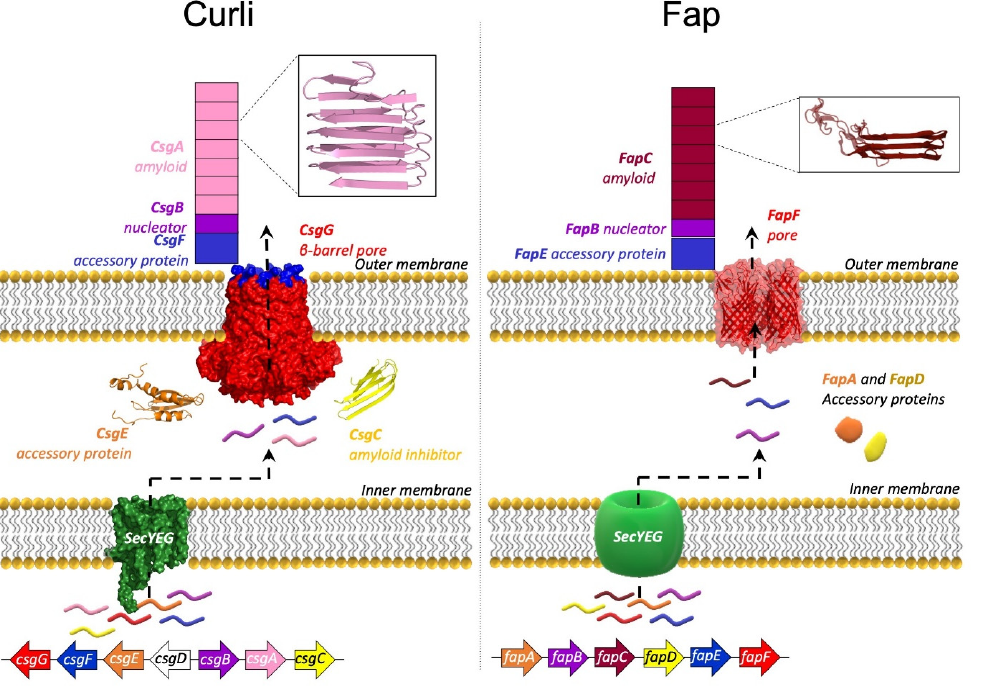
Figure 2. The proteins involved in curli biogenesis are encoded from two divergently transcribed operons, whereas the Fap proteins are encoded from a single operon. The proteins in both systems are transported across the inner membrane through the Sec secretion pathway. The major amyloid components of curli and Fap, CsgA and FapC, respectively, are kept monomeric with the help of chaperone-like accessory proteins, during their transport through the periplasmic space. In each system, the amyloid components are transported to the outer membrane, through their respective pore proteins, CsgG (PDB ID 6SI7) and FapF (PDB ID 5O65). The nucleator proteins CsgB and FapB prime the aggregation of CsgA and FapC, respectively, once the proteins have reached the outer membrane. The insets show structural models of CsgA and FapC. Both CsgA and FapC are pre- dicted to form a β -helix, where the imperfect repeat sequences are stacked on top of each other.